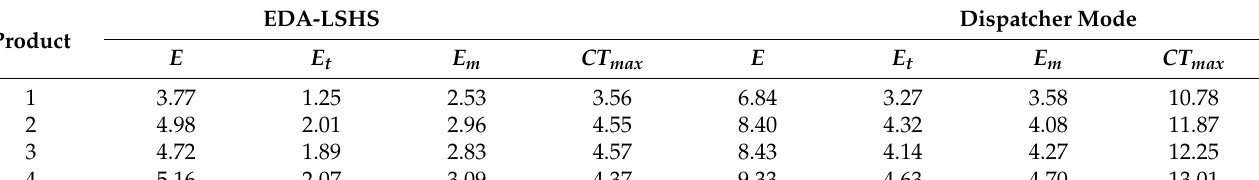
Table 3. Results for the EDA-LSHS algorithm and the dispatcher mode.